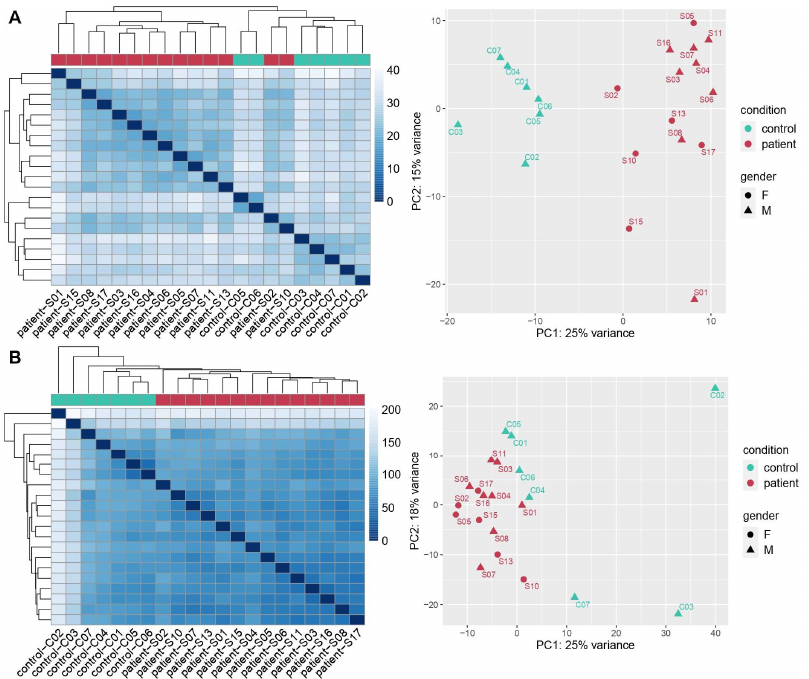
Figure 1. Cases distribution according to distance-based hierarchical clustering heatmaps and prin- cipal component analysis (PCA) graphs related to Nanostring ( A ) and total RNA-Seq ( B ) results, respectively. The heatmaps are a color-coding graphical representation of data coming from transcrip- tome analyses according to differentially expressed genes (DEGs) distribution. These plots were built using the Pheatmap package in R achieved by hierarchical, agglomerative clustering methods. The PCA graph depicts variation within and between the two groups. Both representations for the two methods of analysis showed a clear separation between COVID-19 patients (samples) and